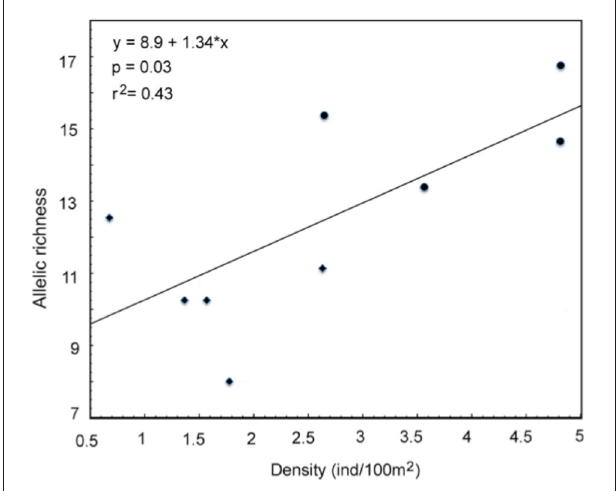
FIGURE 2 | Relationship between allelic richness and fish density in Amphiprion ocellaris (Diamond: Barrang Lompo, Circle: Samalona).